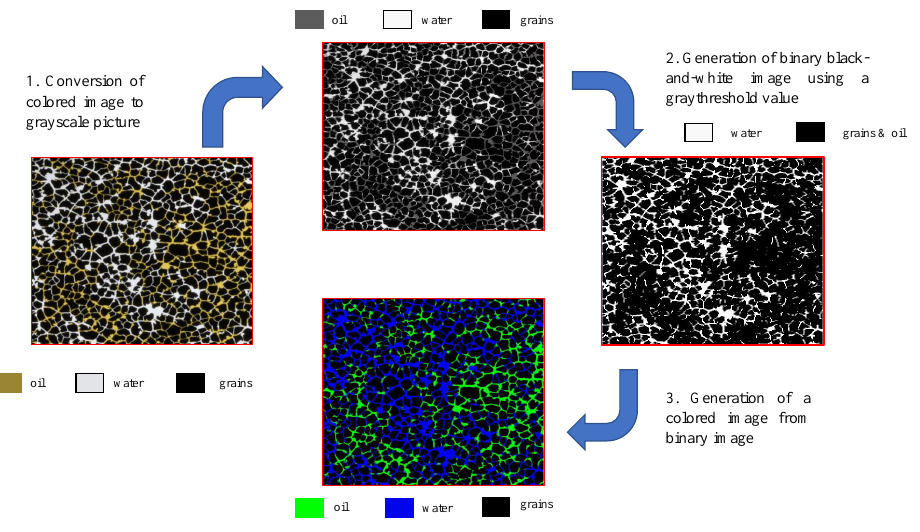
Figure 4. Procedure of converting the original image into a grayscale picture, followed by a binary image and developing the colored image. Simultaneously, the saturations were